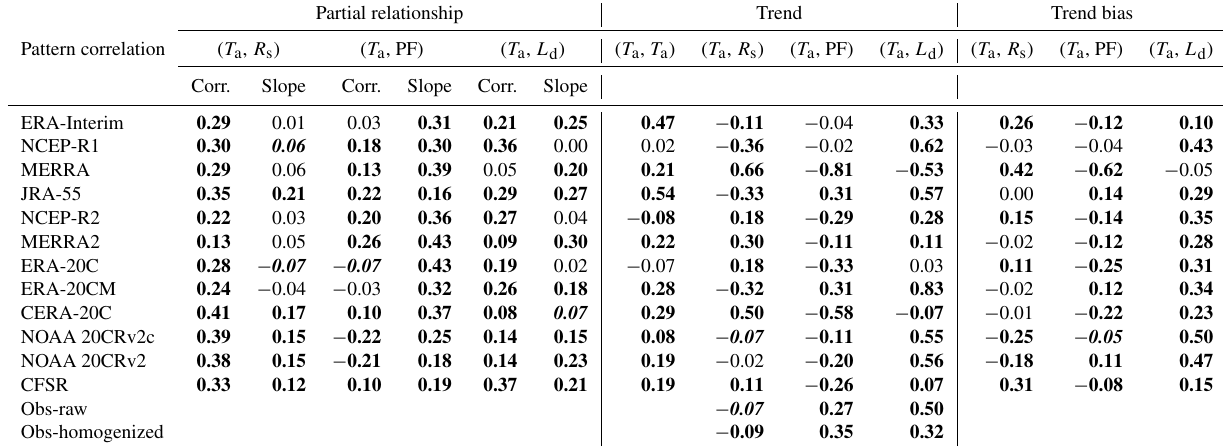
Table 3. Spatial pattern correlation (unit: 1) of three groups: partial relationships, trends and simulated biases in the trends in surface air temperature ( T a ) against surface incident solar radiation ( R s ), precipitation frequency (PF) and surface downward longwave radiation ( L d ). The bold and italic bold fonts indicate results that are significant according to two-tailed Student’s t tests with significance levels of 0.05 and 0.1,